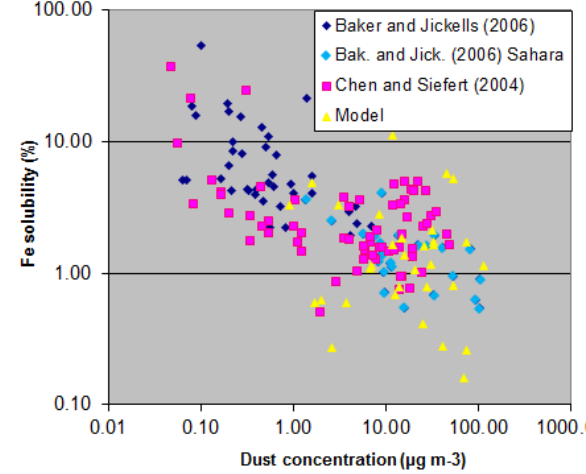
Fig. 6. Iron solubility versus dust concentration. Light and dark blue Figure 6. Iron solubility versus dust concentration. Light and dark blue diamonds are observations from Baker and Jickells (2006) (originating from Sahara and from other sources, respectively) and diamonds are observations from Baker and Jickells (2006) (origi- pink squares are observatuions from Chen and Siefert (2004). Yellow triangles are the model values. nating from Sahara and from other sources, respectively) and pink Baker and Jickells observations for dust concentration smaller than about μg m -3 relate to samples squares are observations from Chen and Siefert (2004). Yellow tri- that had spent at least 5 days over the ocean before collection. 621 angles are the model values. Baker and Jickells (2006) observations for dust concentration smaller than about µgm − 3 relate to samples that had spent at least 5 days over the ocean before